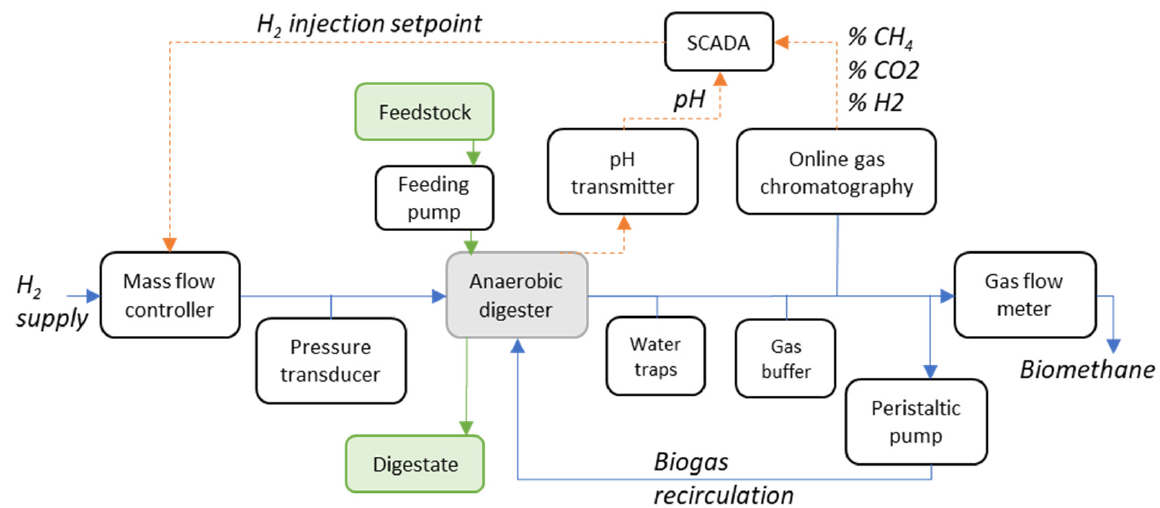
Figure 1. Schematic of the in-situ biomethanation experimental rig.